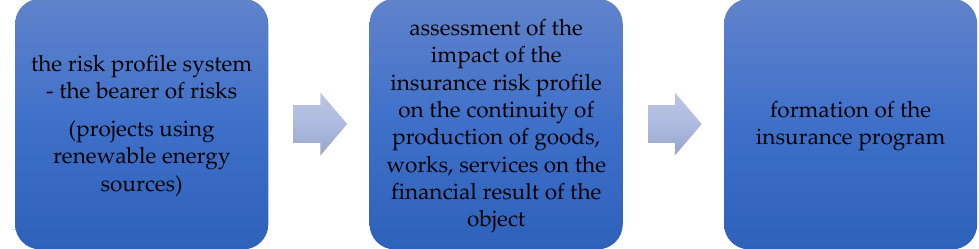
Figure 1. The content and development of insurance systems in the RES projects. Source: authors own design.